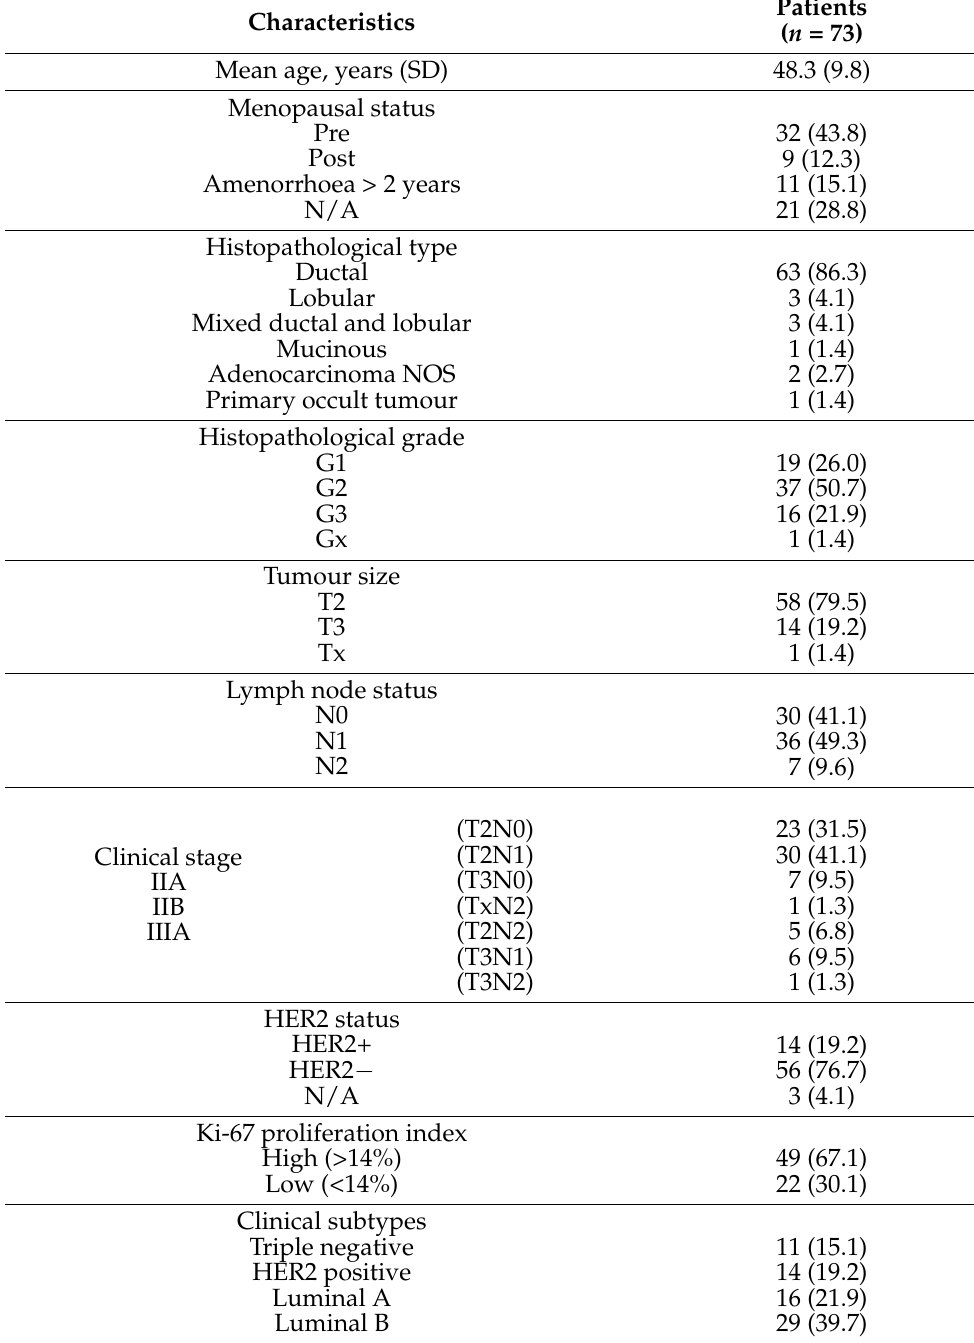
Table 1. Baseline patient and tumour